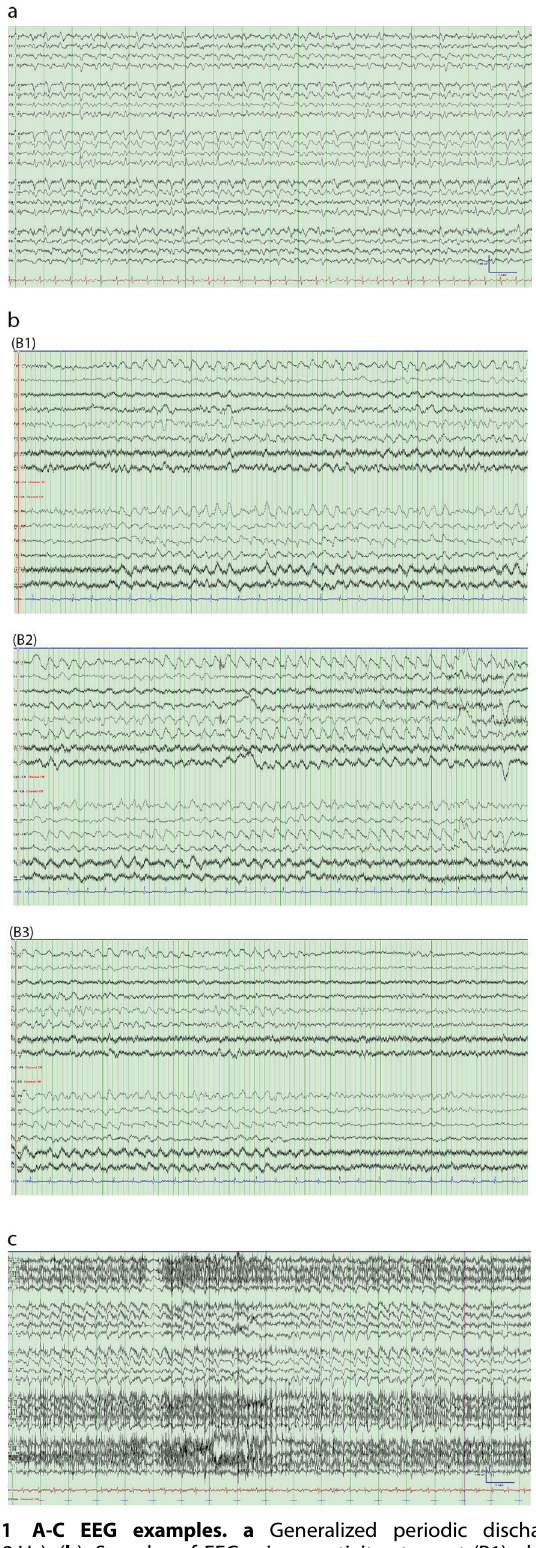
(Table 1a). The dual signi fi cance of generalized